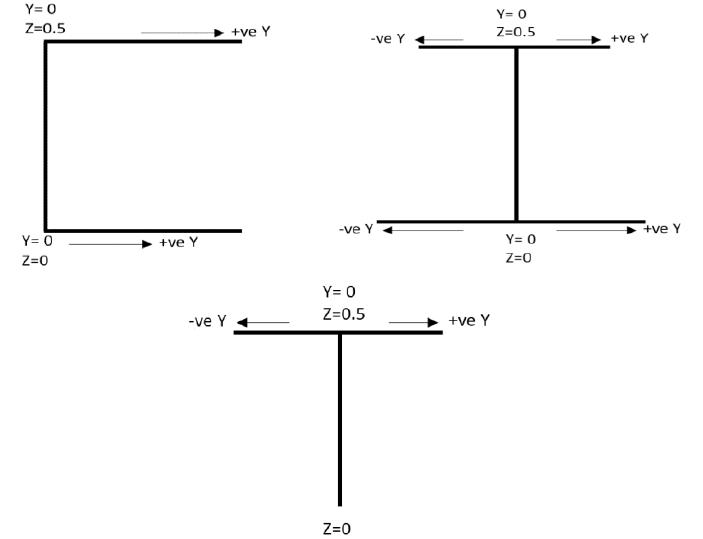
Figure 1: Cross-sections C, I and T of